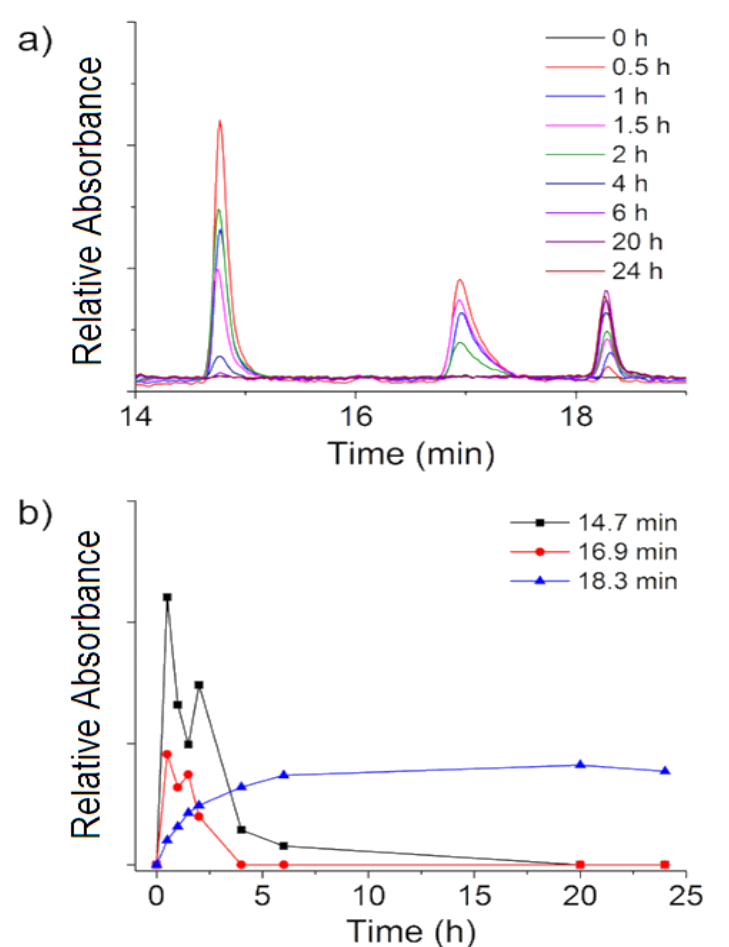
Figure 5. ( a ) Time-dependent HPLC chromatogram evolution under irradiation of a RuBIS CPNs colloidal suspension (200 μg/mL). ( b ) Plot of the time-dependent variation of relative UV absorption of each component (at given retention times) upon irradiation. Detection wavelength: λ = 305 nm.